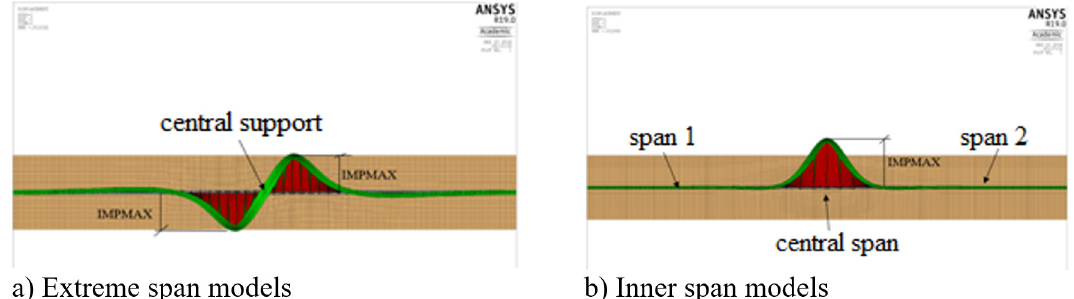
Figure 6. Geometric imperfection applied in parameterization models.